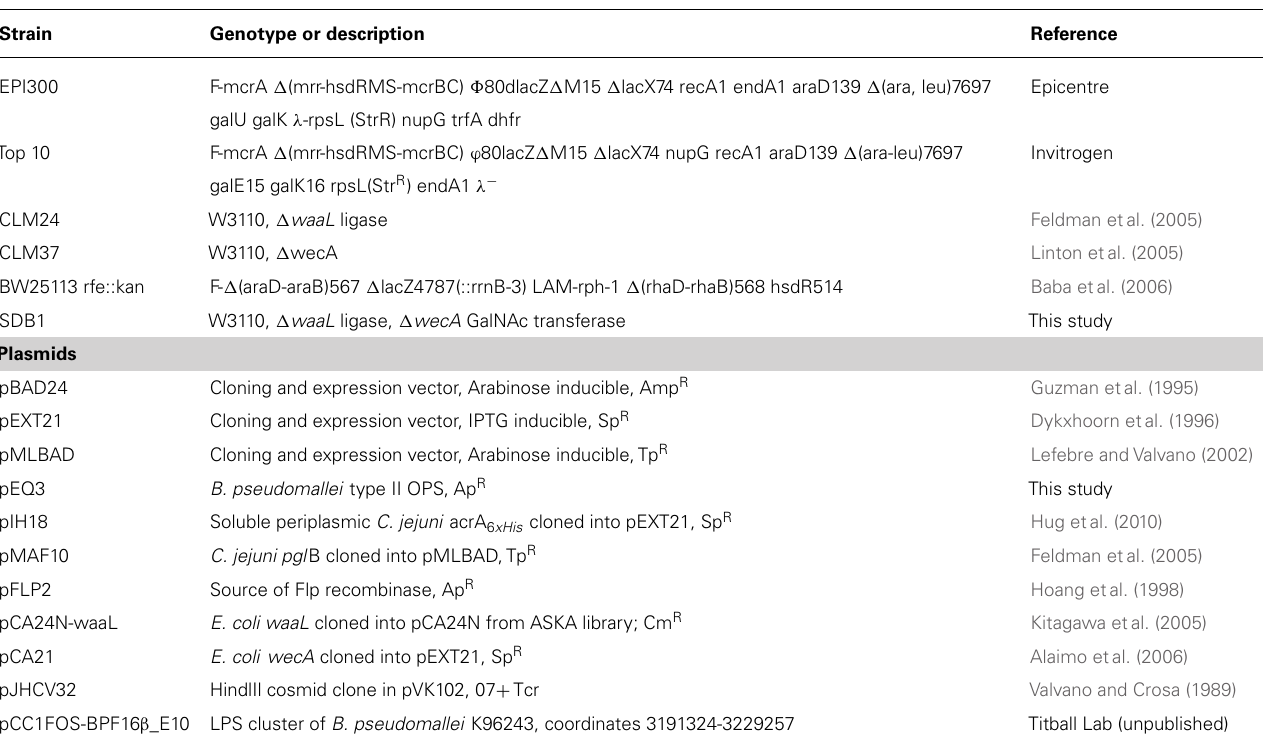
Table 1 | List of strains and plasmids utilized.